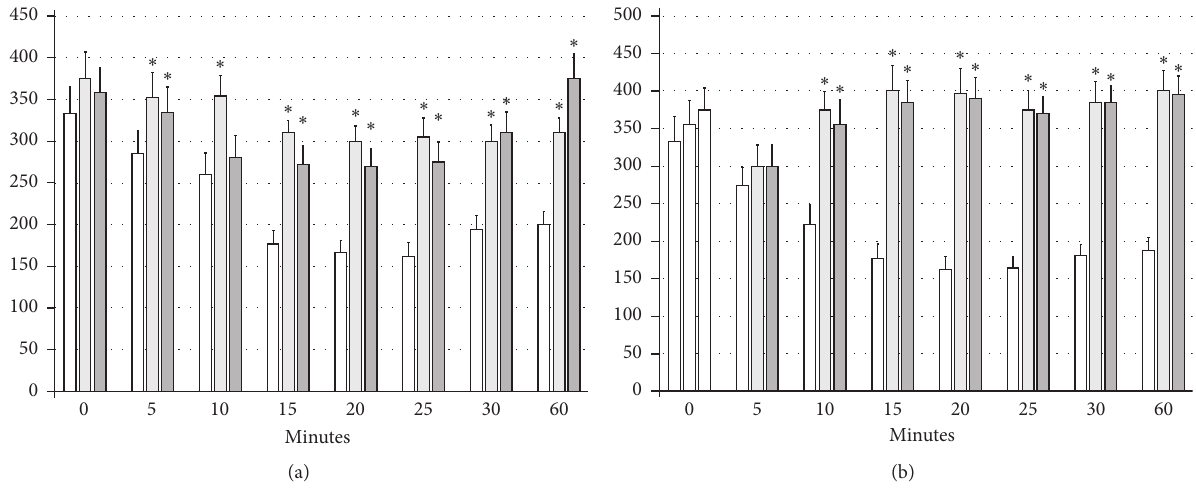
Figure 1: Bradycardia: the intraperitoneal application of lidocaine (80mg/kg) induced significant bradycardia within minutes (white bars) which BPC 157 opposed (gray bars). Prophylactic effect: the application of BPC 157 (10 μ g/kg (light gray bars) or 10ng/kg (dark gray bars)) counteracted the development of lidocaine-induced bradycardia (given 30 minutes before the application of lidocaine) (a). Therapy effect: BPC 157 (10 μ g/kg (light gray bars) or 10ng/kg (dark gray bars)) reversed (given immediately after lidocaine) the already established lidocaine-induced bradycardia) (b). ∗ P < 0 . 05 at least vs . control. Heart frequency, beats/min; values are presented as mean ± SD.